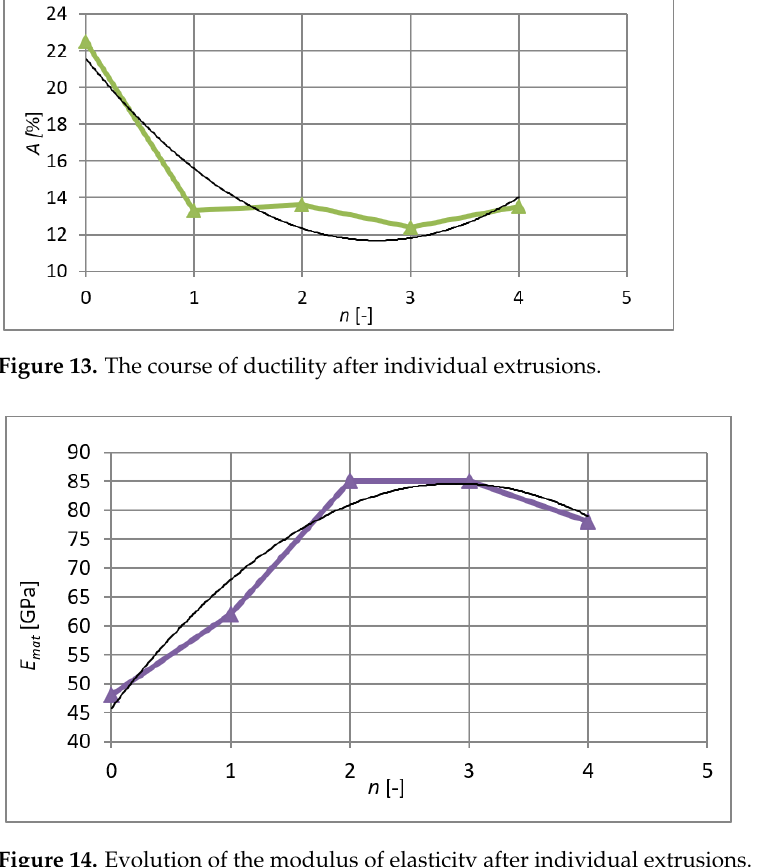
Figure 13. The course of ductility after individual extrusions.